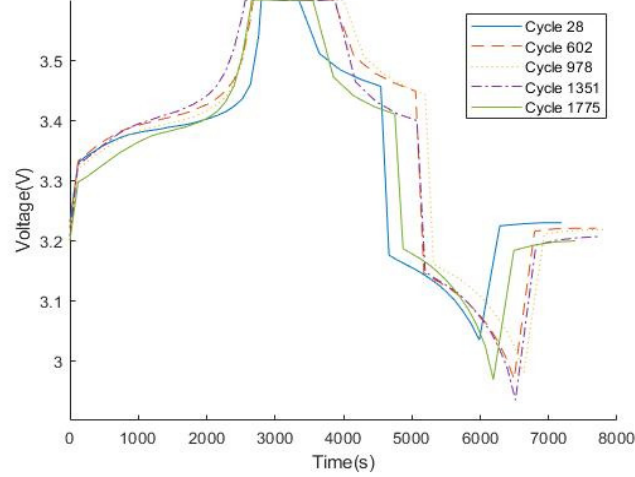
Figure 7 . Voltage curves in different cycling test cycles. The data-driven methods and the KFs are used to predict the SOH of the battery based on the cycling test data and the generalized model. The modelling error is between 1.1% and 1.5%, slightly lower than capacity test data and superior to the generalized semi-empirical model [19] with a modelling error of 1.9%, as shown in Figure 8 and Table 3.